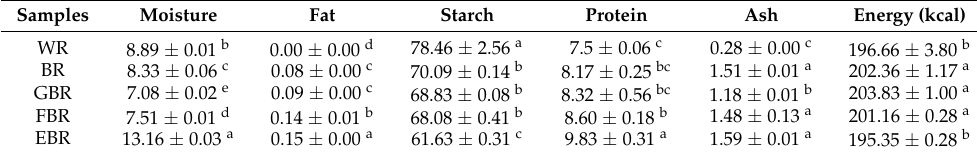
Table 1. Basic components in different brown rice products (g/100g dry weight, DW). Samples Moisture Fat Starch Protein Ash Energy